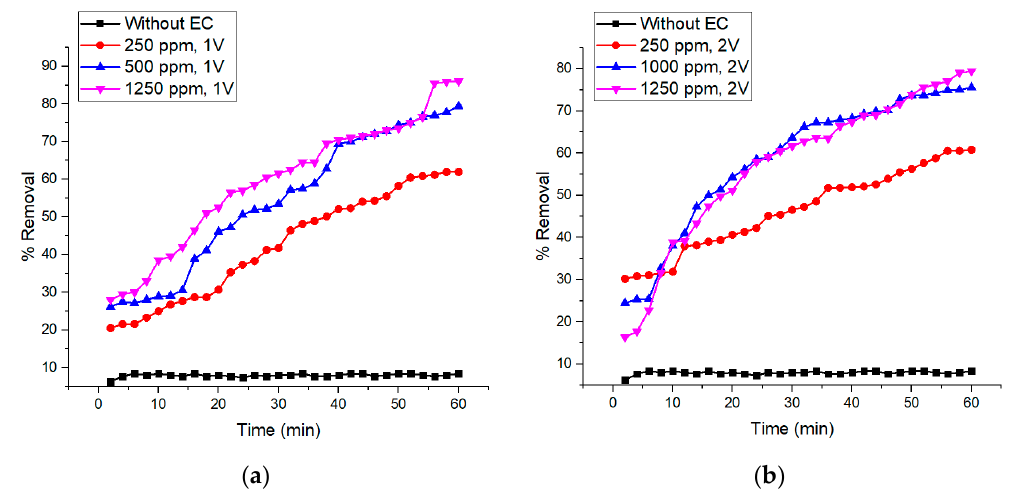
Figure 5. Comparison of the dye removal treatment with and without electrocoagulation (EC) using ( a ) 250, 500 and 1250 ppm of NaCl at 1 V and ( b ) 250, 1000 and 1250 ppm of NaCl at 2 V at pH 7 using 10 ppm of celestine blue solution.